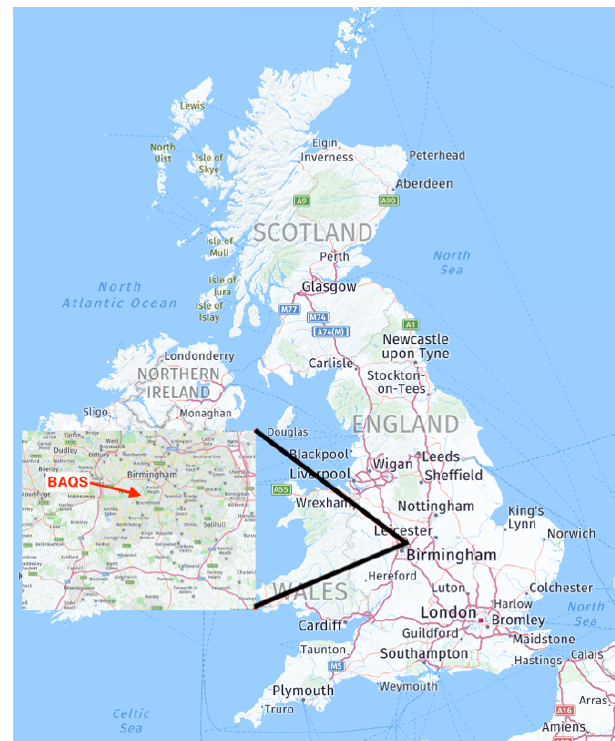
Figure 1. Map of the location of the Birmingham Air Quality Su- persite (BAQS) in the UK (Map by ©